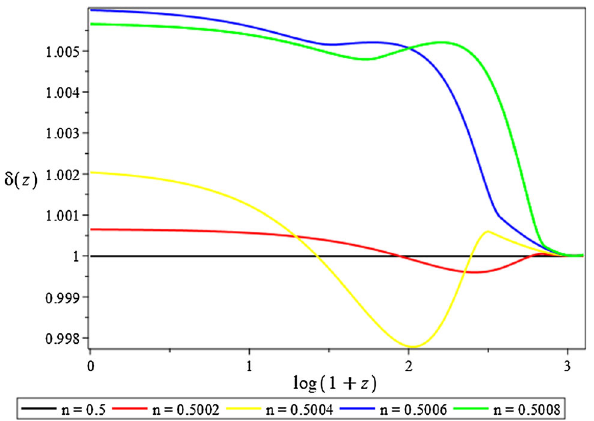
Fig. 5 δ( z ) versus z forEq.(100)inthetorsion-dustsystemfor n closer to 1